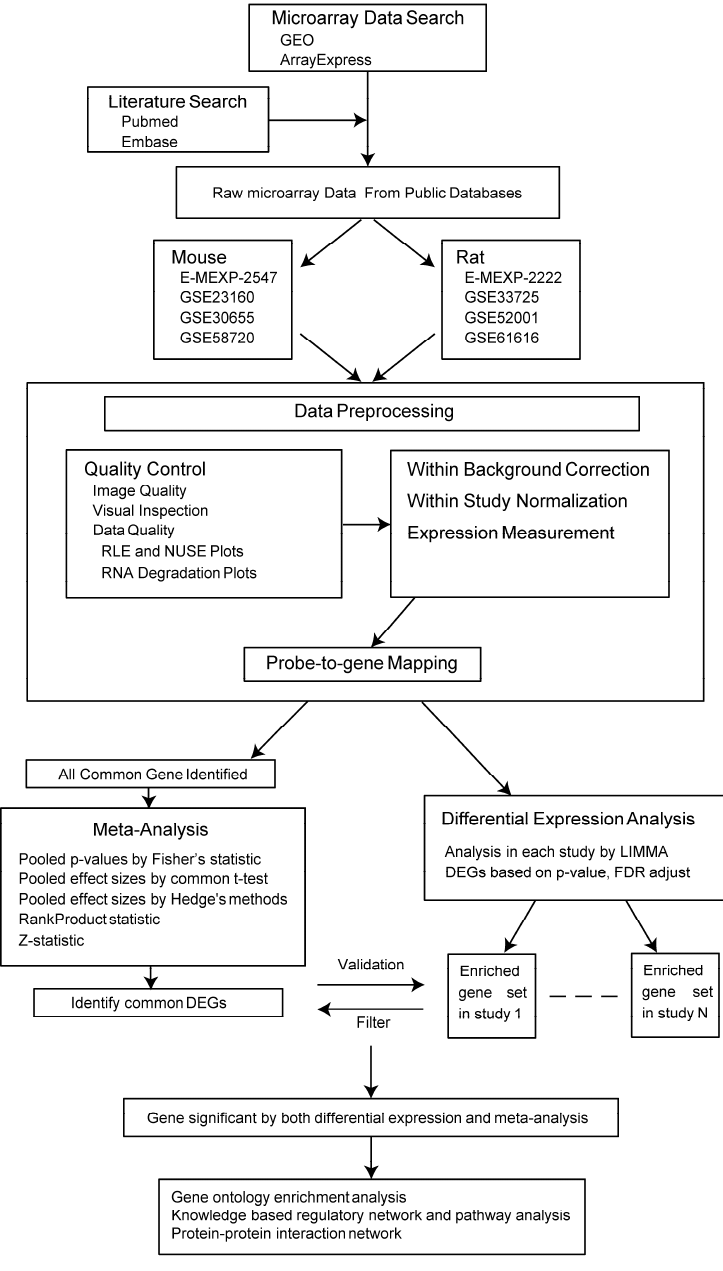
Figure 4. A summary of analysis workflow. RLE, relative log expression; NUSE, normalized unscaled standard errors; DEGs, differentially expressed genes. Solid line with arrow refers to directed workflow. Dash line refers to enriched gene sets of several studies